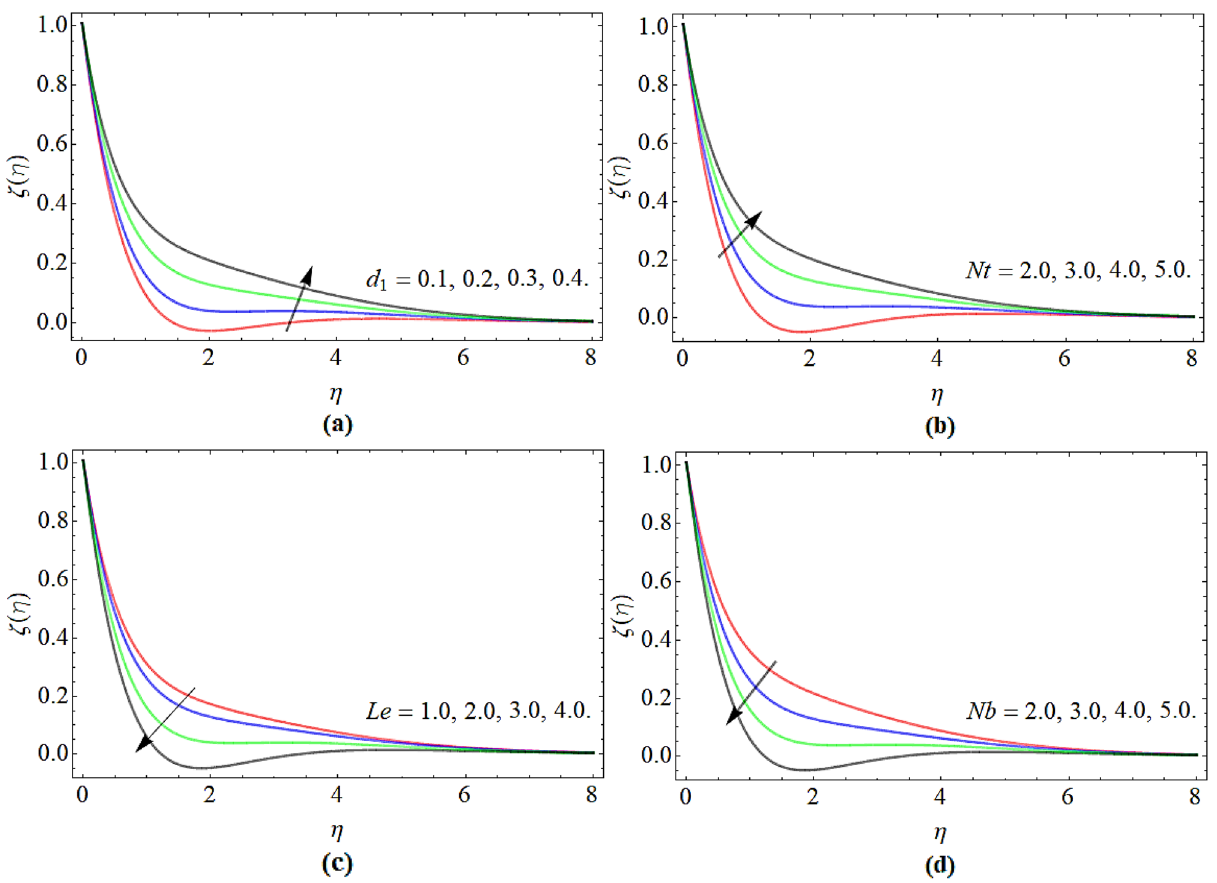
Figure 4. The nature of nanoparticles concentration ϕ(η) profile versus ( a ) chemical reaction d 1 , ( b ) thermophoresis constant Nt , ( c ) Lewis number Le , ( d ) Brownian motion Nb